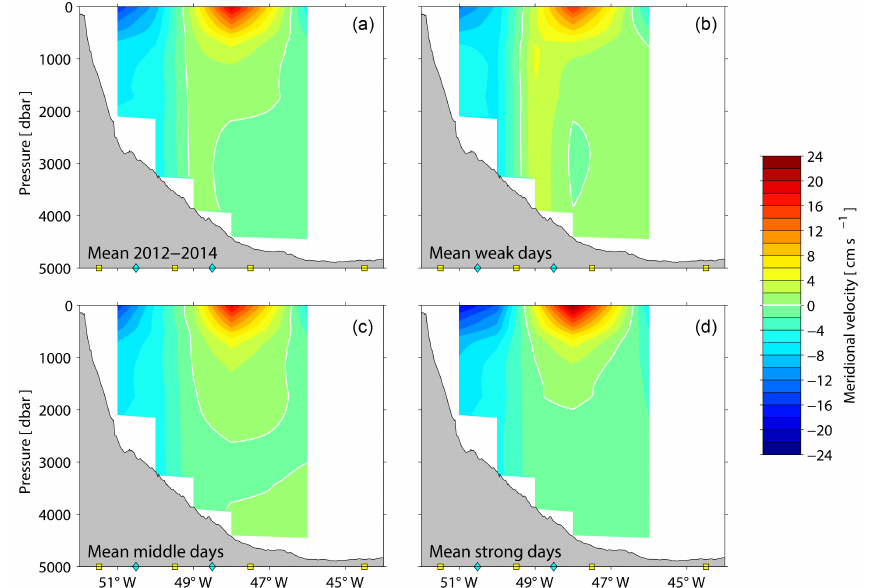
Figure 9. Composite meridional velocity sections based on the average of all data when the enhanced array is in place, December 2012– October 2014 (top left), the average of all days when the southward DWBC transport is within ± 2 standard errors around the mean value (“middle” – lower left), the average of the days where the southward DWBC transport is weaker than the mean minus 2 standard errors (“weak” – top right), and the average of the days where the southward DWBC transport is stronger than the mean plus 2 standard errors (“strong” – lower right). Gray shading indicates bottom topography; symbols along the bottom of each panel indicate the PIES and CPIES sites. Note the color-bar range is different than for Fig. 2. White contours in all panels indicate zero flow.